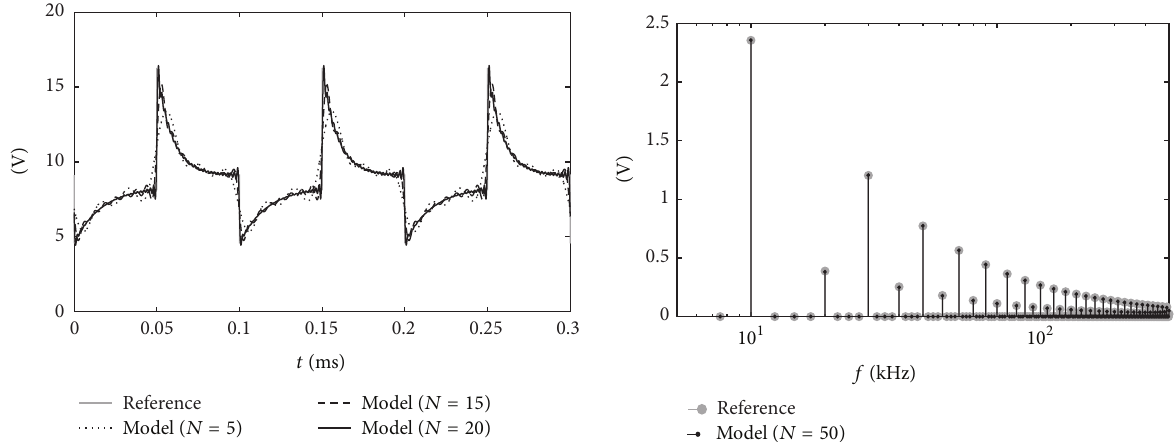
Figure 5: Time-domain (steady-state) responses of the voltage V 2 (𝑡) for the circuit of Figure 3 and its corresponding frequency-domain spectrum. The reference time-domain response (computed by means of the ODE-based routines in MATLAB) is compared with the solutions arising from (29) and different values of the order of expansion 𝑁